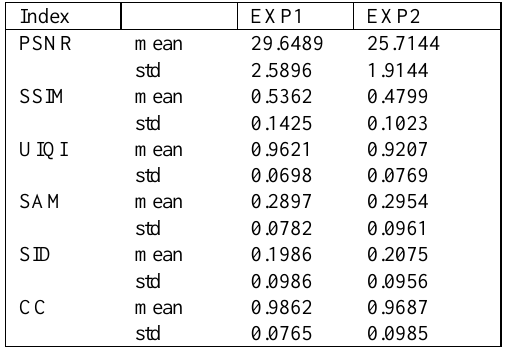
Figure 11 . Recreation of snowy image patches of EXP1 (a) ground truth image (0.5 m) (b) Output